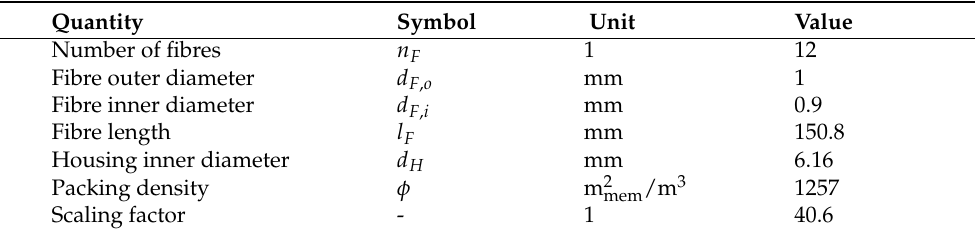
Table 4. Geometric parameters of the down-scaled hollow fibre membrane humidifier.